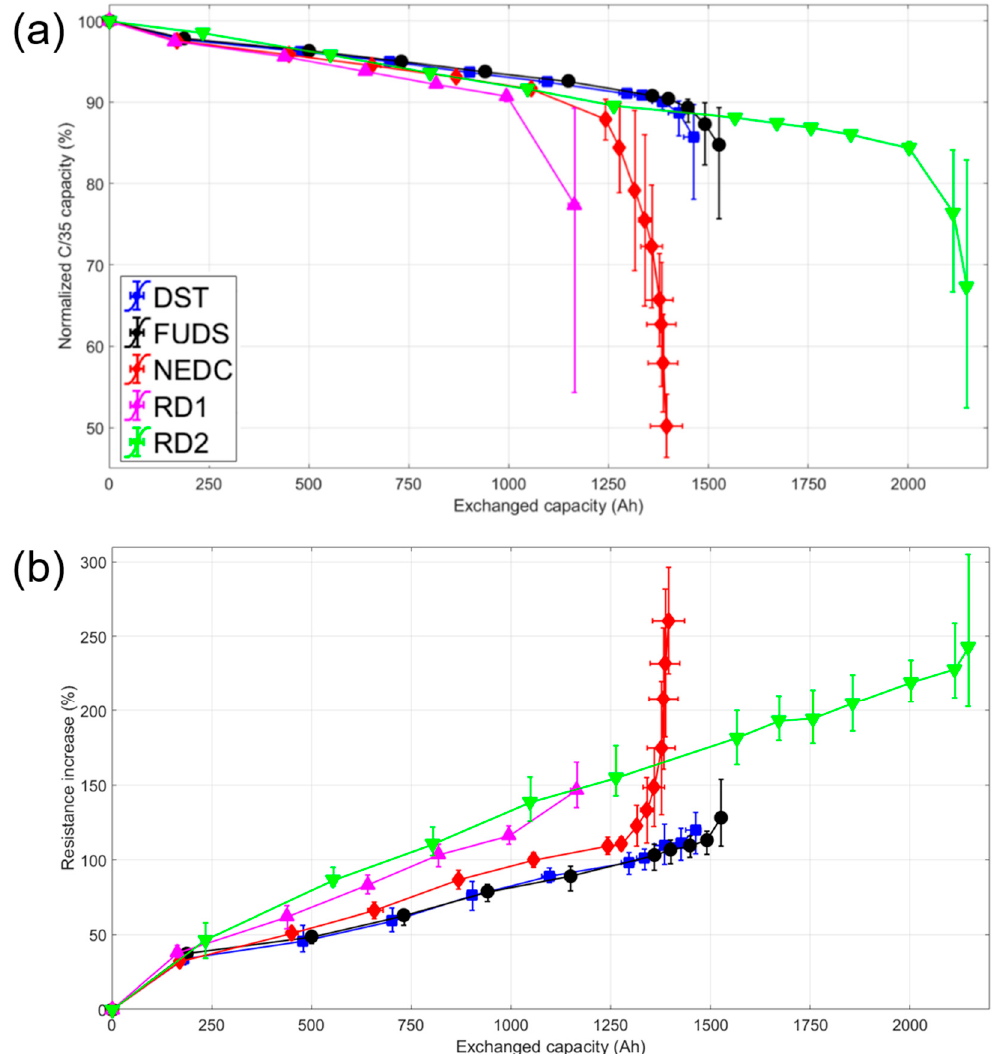
Figure 3. Plots of the average ( a ) normalized capacity and ( b ) resistance increase for each of the driving profiles vs. exchanged capacity.